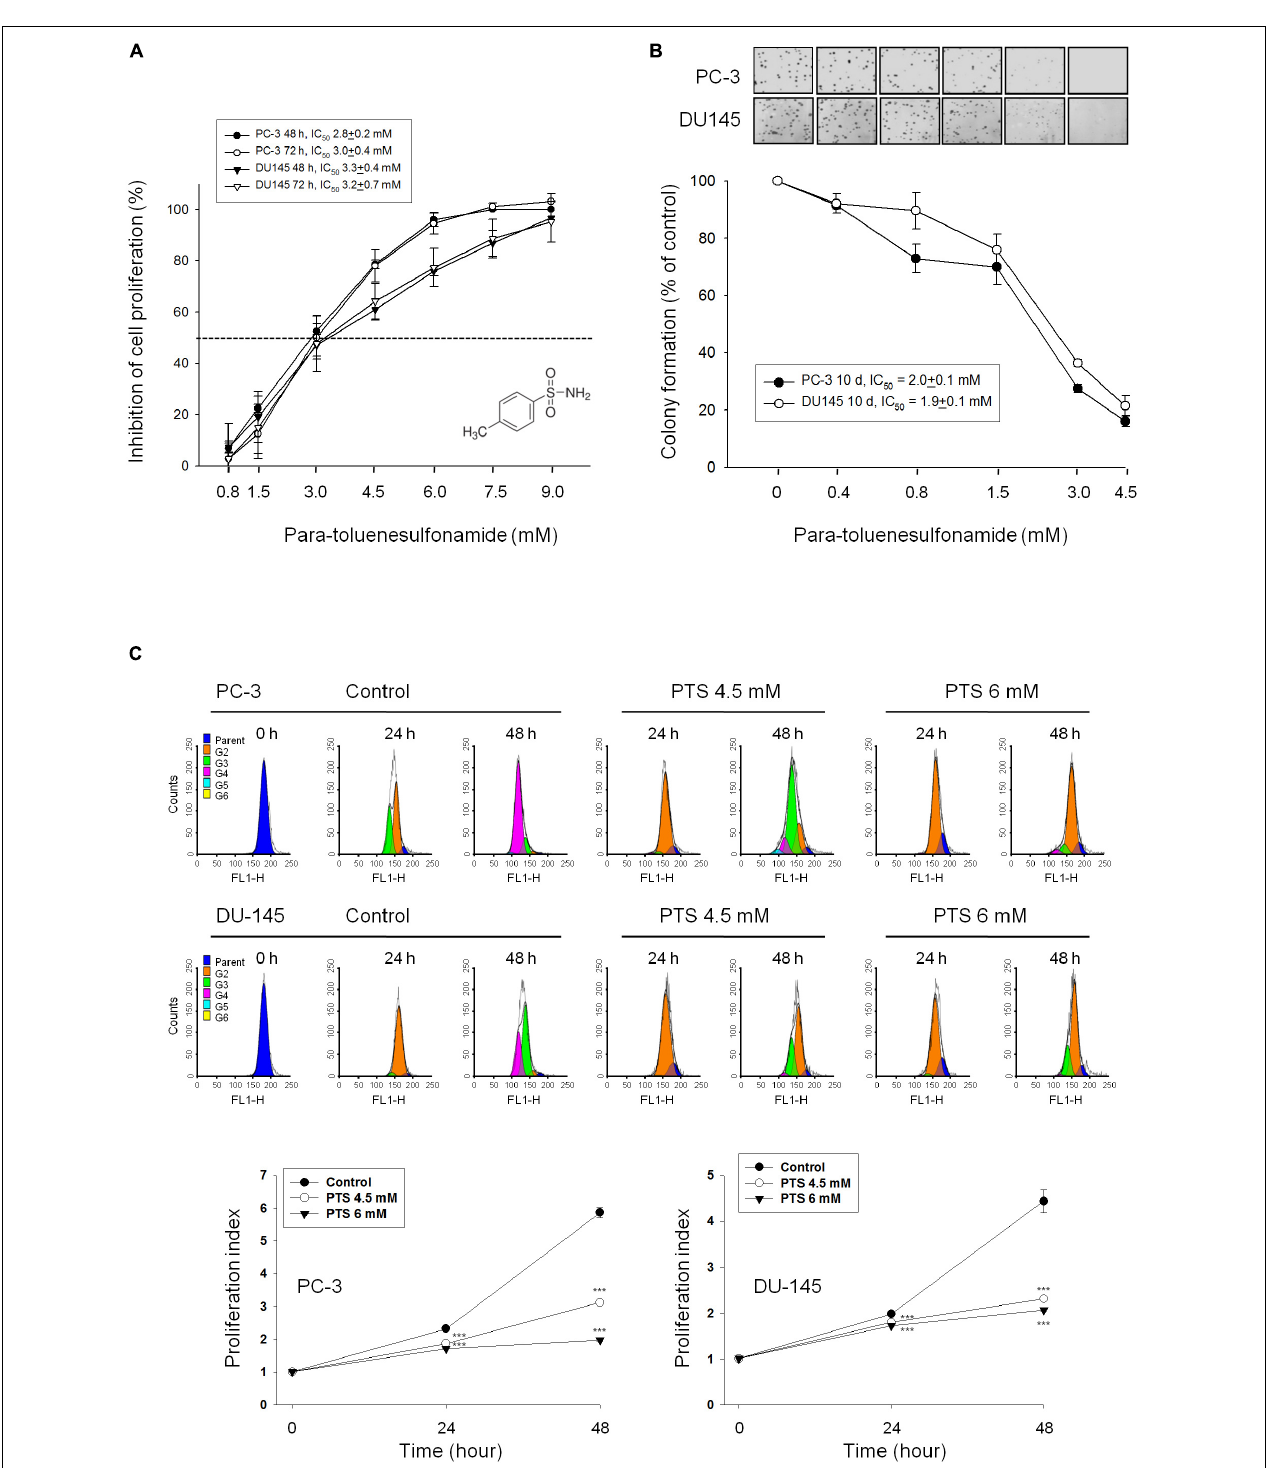
FIGURE 1 | Anti-proliferative effects of para-toluenesulfonamide (PTS) on human castration-resistant prostate cancer cells. The cells were incubated in the absence or presence of PTS for different duration. After treatment, cells were fixed and stained for SRB assay (A) and colony formation assay (B) . (C) PC-3 and DU-145 cells were incubated with or without PTS. After treatment, cells were harvested for flow cytometric analysis of CFSE staining. The proliferation index and the cell populations of parent or different generations were calculated by Modfit LT Version 3.2 and WinList Version 5.0 software. Quantitative data are expressed as mean ± SD of three to four independent experiments. ∗∗∗ P < 0.001 compared with the control.